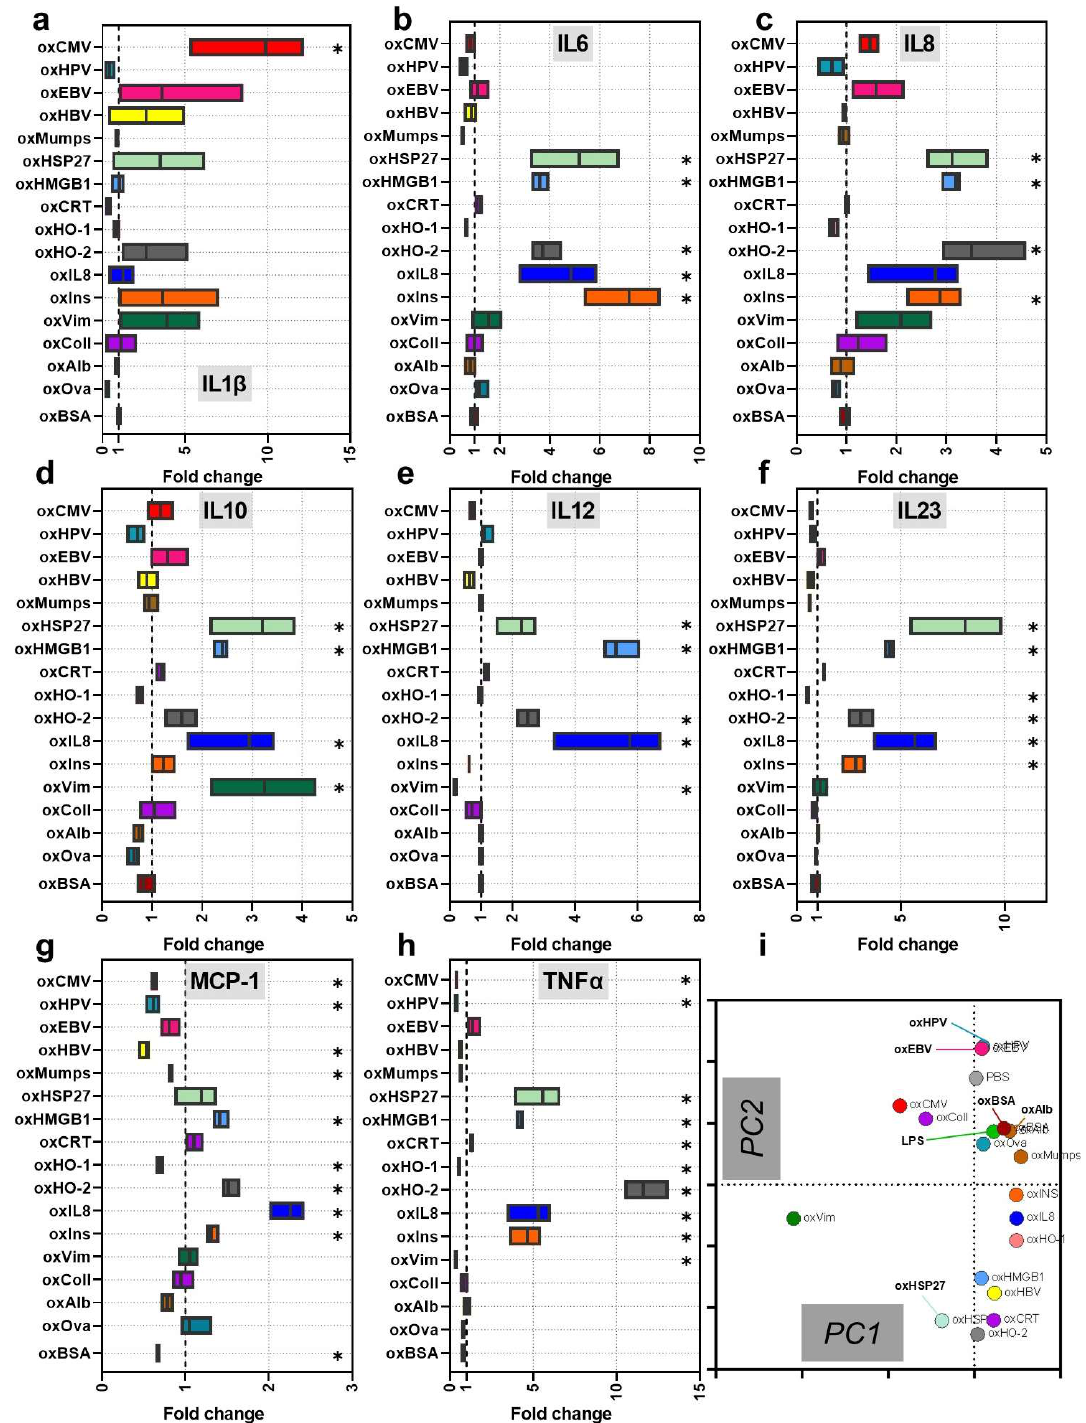
Figure 4. Secretion profiles of monocyte-derived cells incubated with oxProteins. ( a – h ) stimulated monocyte-derived cells’ supernatants were analyzed for cytokines using a multiplex assay: IL1β ( a ), IL-6 ( b ), IL8 ( c ), IL10 ( d ), IL12 ( e ), IL23 ( f ), MCP-1 ( g ), and TNFα ( h ); ( i ) principal component analysis of surface marker and secretion profiles. Data are mean of technical replicates of an assay with six independent experiments. Gas plasma-treated proteins were normalized to each corresponding native protein. Statistical analysis was performed using Mann–Whitney Test by comparing the oxidized proteins to the native (significances p < 0.05, p < 0.01, p < 0.001 are grouped and given as *).